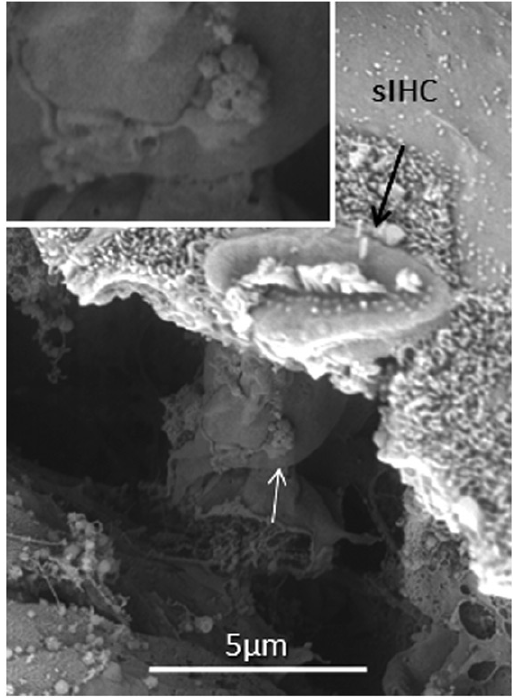
Figure 10. FESEM of a human sIHC at a place where the reticular lamina was ruptured. A synaptic terminal is seen on the lateral wall the cell